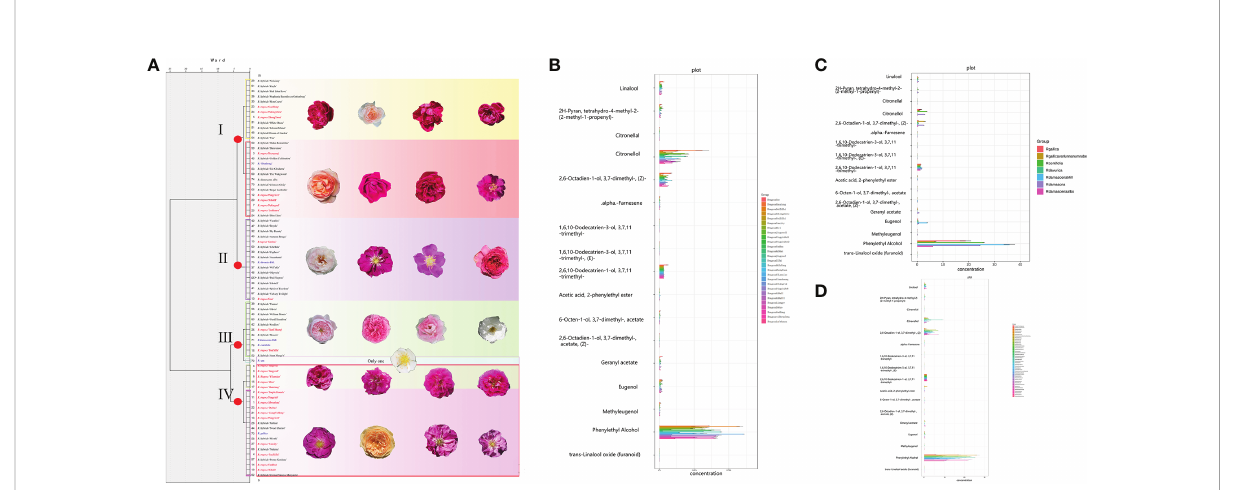
FIGURE 2 Cluster analysis of morphological characters and histogram of target metabolites in Rosa accessions. The unit for the fl oral scents is m g/g. (A) Dendrogram based on similarity in morphological characters. (B) Histogram of target metabolites in 27 R. rugosa cultivars. (C) Histogram of target metabolites in 43 fragrant R. hybrida cultivars. (D) Histogram of target metabolites in seven fragrant Rosa